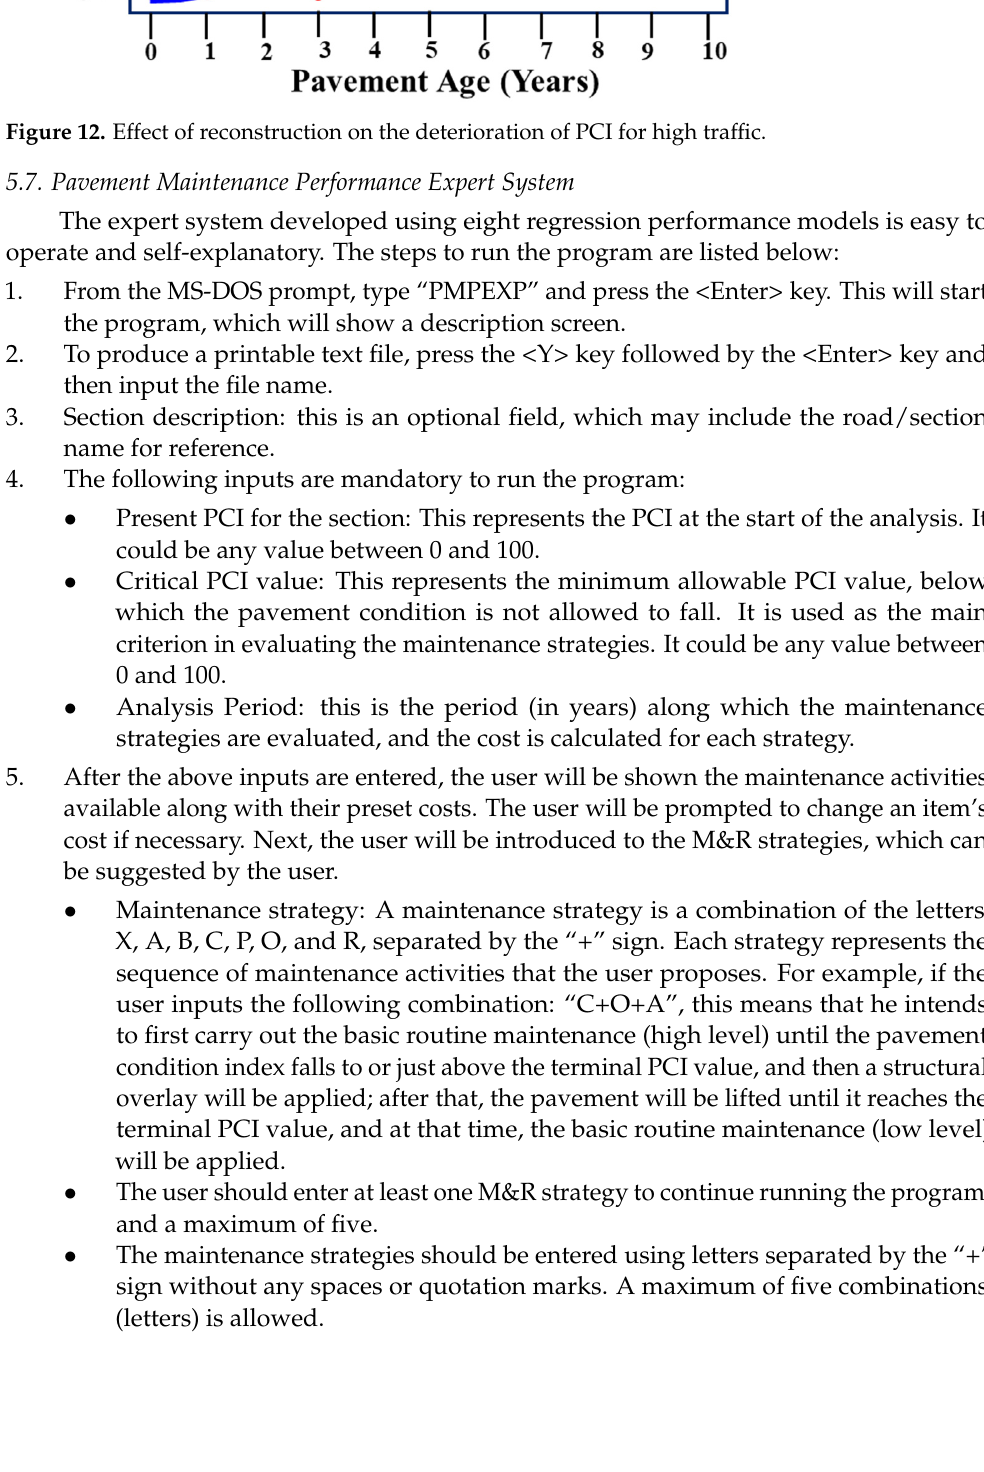
Figure 12. Effect of reconstruction on the deterioration of PCI for high traffic.